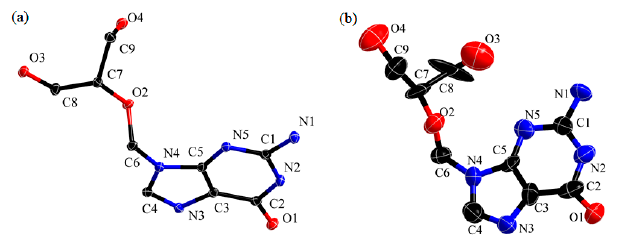
Figure 2. The molecular structure of: ( a ) anhydrous form I (CCDC refcode: UGIVAI01, 50% proba- bility level); ( b ) anhydrous form II (CCDC refcode: UGIVAI, 50% probability level) [19]. Hydrogen atoms were omitted for clarity. The different temperatures at which diffraction data were collected (form I: 100 K, form II: 293 K) had no effect on the occurrence of the two crystalline forms them- selves.